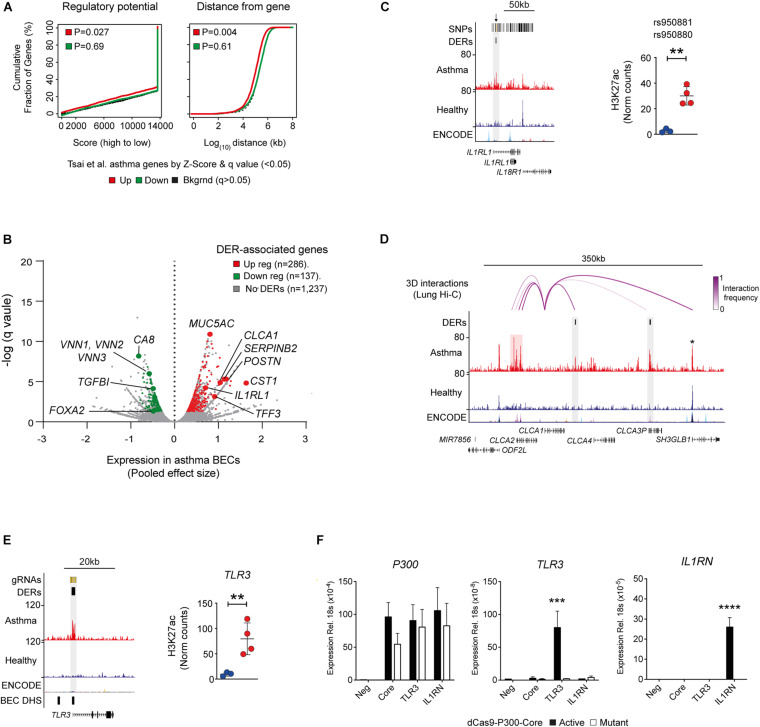
Relationship between H3K27ac and gene expression in asthma. (A) Plots generated by BETA analysis depicting the relationship between DERs and Asthma gene expression in airway epithelium identified by Tsai et al. (2018). Overall, gain in H3K27ac was associated with transcriptional activation (up regulated genes—red) and was closely related to genomic distance. (B) DER-associated genes and respective upregulation (red) and downregulation (green) in asthma identified by Tsai et al. (2018) (see Supplementary Table S5). (C) Genome tracks and dot plot depicting H3K27ac of DERs overlapping asthma SNPs at IL1RL1 (orange lines and arrows, top track) in healthy (blue) and asthma (red) BECs. (∗∗P < 0.01, DiffBind). (D) Genome tracks depicting H3K27ac in BECs and long-range chromosomal interactions in lung tissue (top track) across the CLCA1 locus. Although exhibiting minimal H3K27ac in BECs, CLCA1 interacts with asthma DERs spanning ∼200 kb (purple arcs) including those near CLCA3P and an asthma-SE at CLCA2 (highlighted in red). Note that no change in H3K27ac is evident at SH3GLB1 (star). (E) Genome tracks depicting H3K27ac across the TLR3 location of DER-specific gRNAs (top track—orange lines). Regions of “open chromatin” identified in BECs are depicted in the bottom track (DNase hypersensitivity sites—DHS). Dot plots depicting H3K27ac enrichment of DER targeted by gRNAs across healthy (blue) and asthma volunteers (∗∗P < 0.01, DiffBind). (F) Using a CRISPR-based approach, acetylation (dCas9-P300-Core) was targeted to an asthma-DER at TLR3 using pooled guide RNAs. Increased P300 indicated successful delivery and expression of dCas9 constructs across all gRNA pools. However, TLR3 gene expression was selectively induced in a DER-specific gRNA and acetylation-dependent manner. A pool of non-DER-targeting gRNAs to IL1RN was used as control. Core—only P300 constructs transfected (n = 3, Mean ± SEM, ∗∗∗P < 0.001, ANOVA/Tukey multiple comparisons). *⁣*⁣**p < 0.0001.